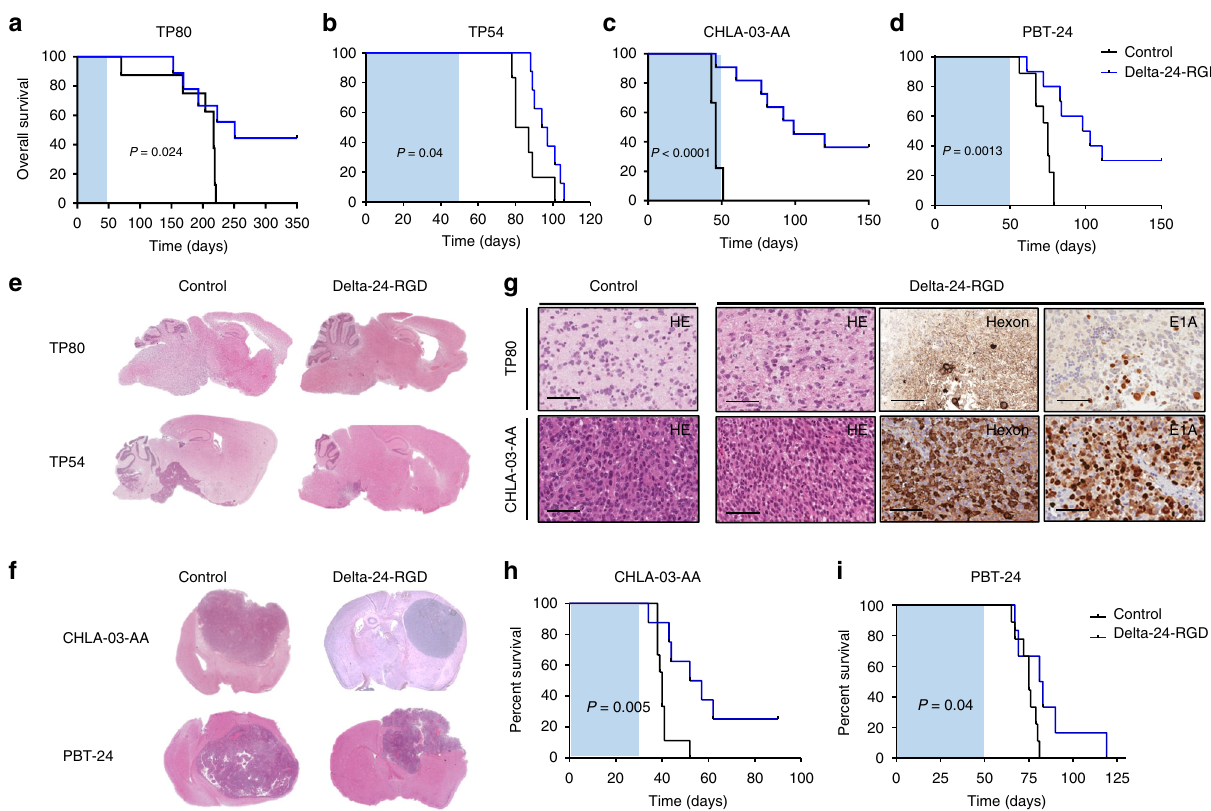
Fig. 3 Delta-24-RGD increases overall survival in DIPG and pHGG models. Tumors were developed by orthotopic intracranial injection of 500,000 cells in female nude mice. a Kaplan – Meier survival curves of Delta-24-RGD (10 8 pfu)- and control (PBS)- treated athymic mice bearing a TP80 (Control N = 8, Delta-24-RGD-treated N = 9), b TP54 (Control N = 8, Delta-24-RGD-treated N = 9), c CHLA-03-AA (Control N = 9, Delta-24-RGD-treated N = 11), and d PBT-24 (Control N = 9, Delta-24-RGD-treated N = 10). Animals were treated 3 days post-tumor cell injection. The shaded area represents a 50-day interval from the time of cell implantation. Log-rank test was used as statistical analyses. e Representative images of the histopathological analyses of TP80 and TP54 (H&E) of longitudinal slides of control (left images) and Delta-24-RGD-treated tumors (right image). f Representative images of the histopathological analyses of CHLA-03-AA and PBT-24 (H&E) (magni fi cation × 1) of control (left image) and Delta-24-RGD-treated (right images). Mice were treated with either PBS (control) or Delta-24-RGD 3 days post injection. For comparison studies, analyzed brains are derived from mice that died at a similar time point in both groups: CHLA-03-AA = 50 ± 10 days; PBT-24 = 60 ± 5 days; TP80 = 200 ± 5 days; TP54 = 90 ± 5 days. g Representative images correspond to the brains shown in e , f . h , i Kaplan – Meier survival curves of established tumors h CHLA-03-AA (Control N = 10, Delta-24-RGD-treated N = 10) and i PBT-24 (Control N = 8, Delta-24-RGD-treated N = 9) treated with Delta-24-RGD 15 days post cell implantation. The shaded area represents a 50-day interval from the time of cell implantation. Source data are provided as a Source Data fi